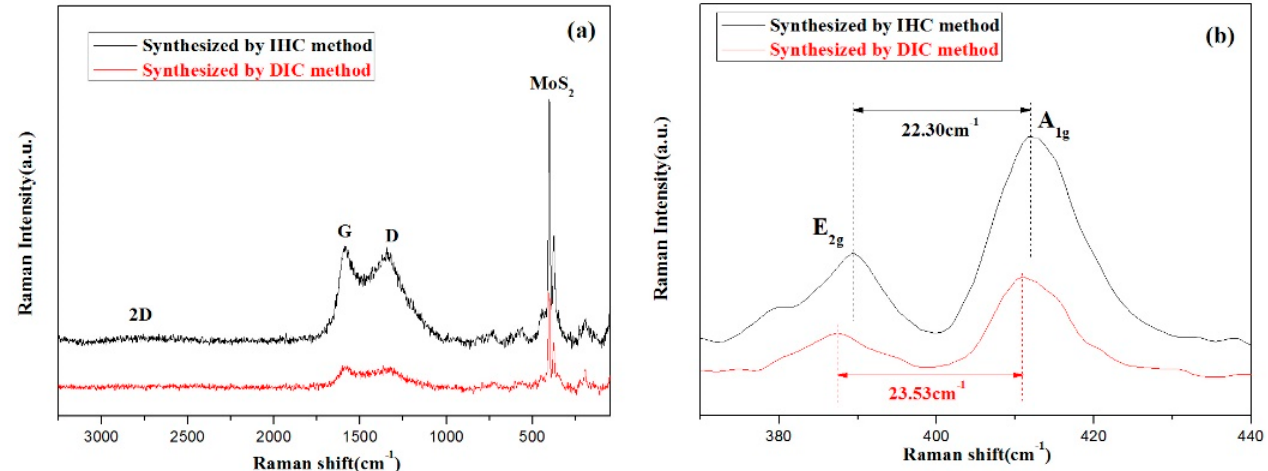
Figure 6. Raman spectra of MoS 2 /biocarbon obtained by DIC method and by IHC method ( a ) enlargement indicating their multilayer characteristics ( b ).